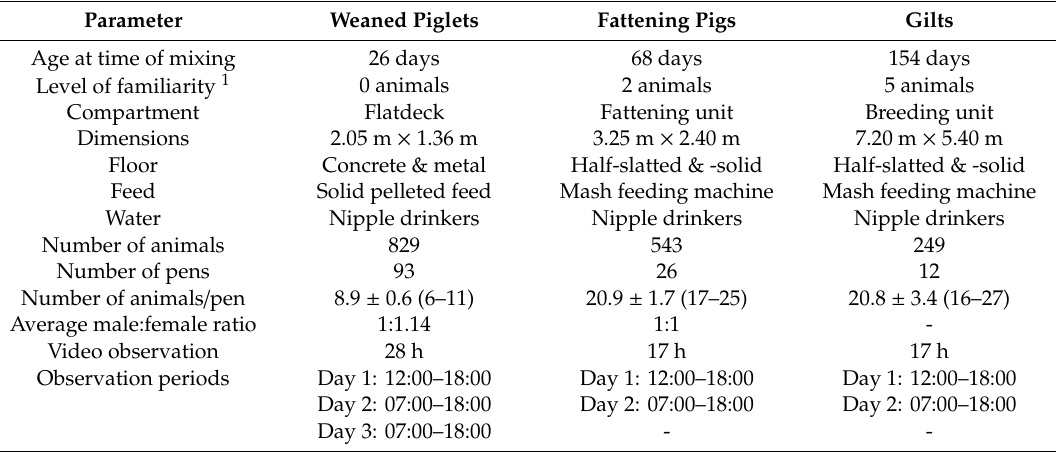
Table 1. Basic information about the study design, housing conditions, involved animals and observation